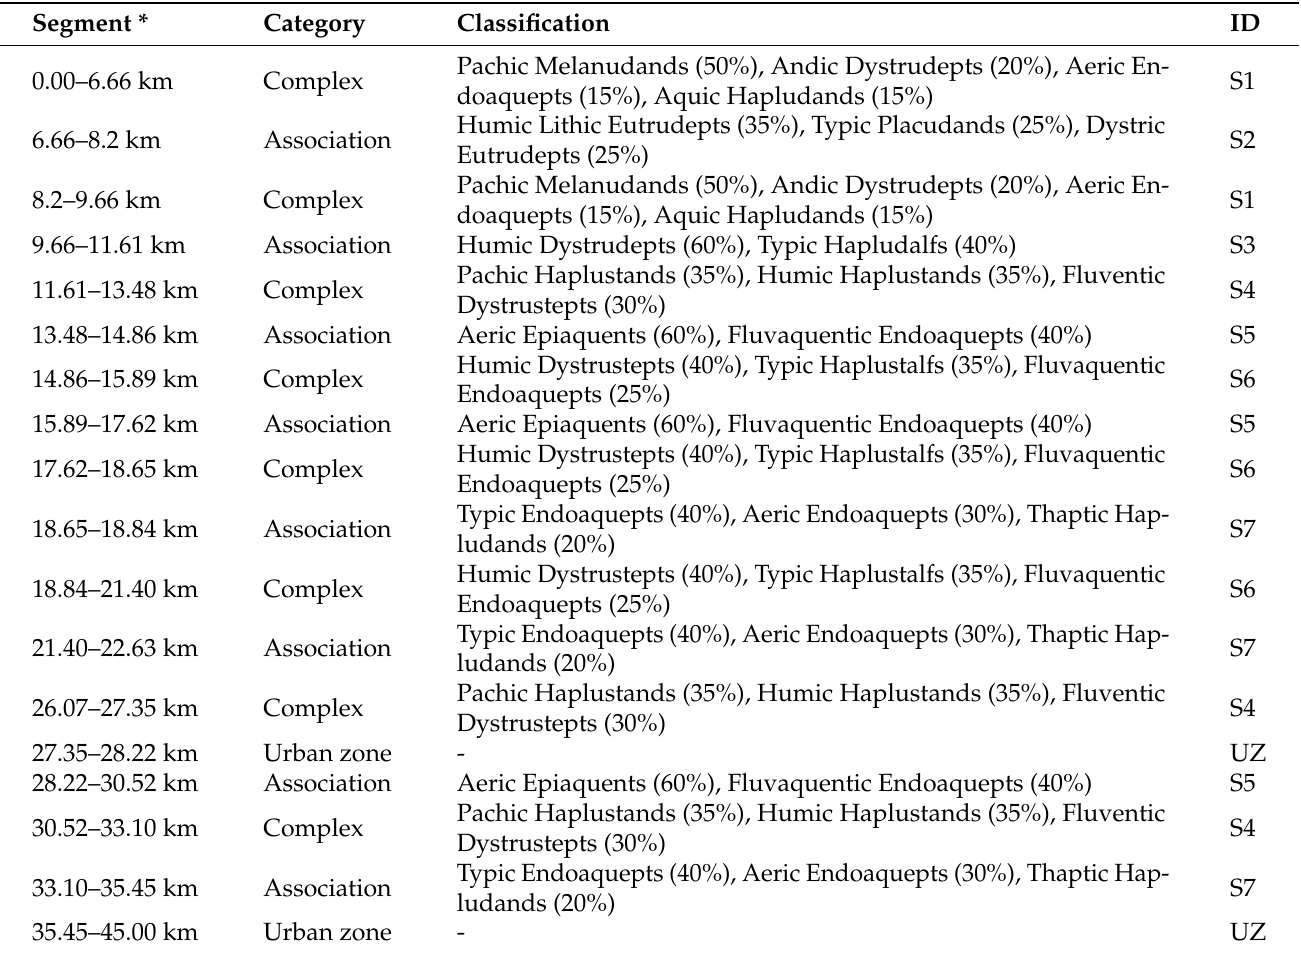
Table 3. Pipeline segmentation based on the United States Department of Agriculture (USDA) soil classification.